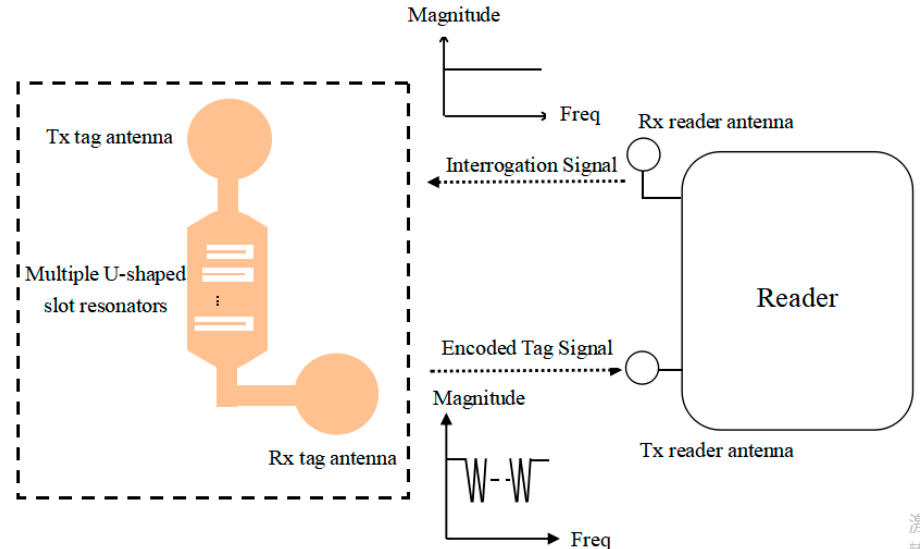
Figure 2. Working principle diagram of multiple U-shaped slot resonator chipless tags.